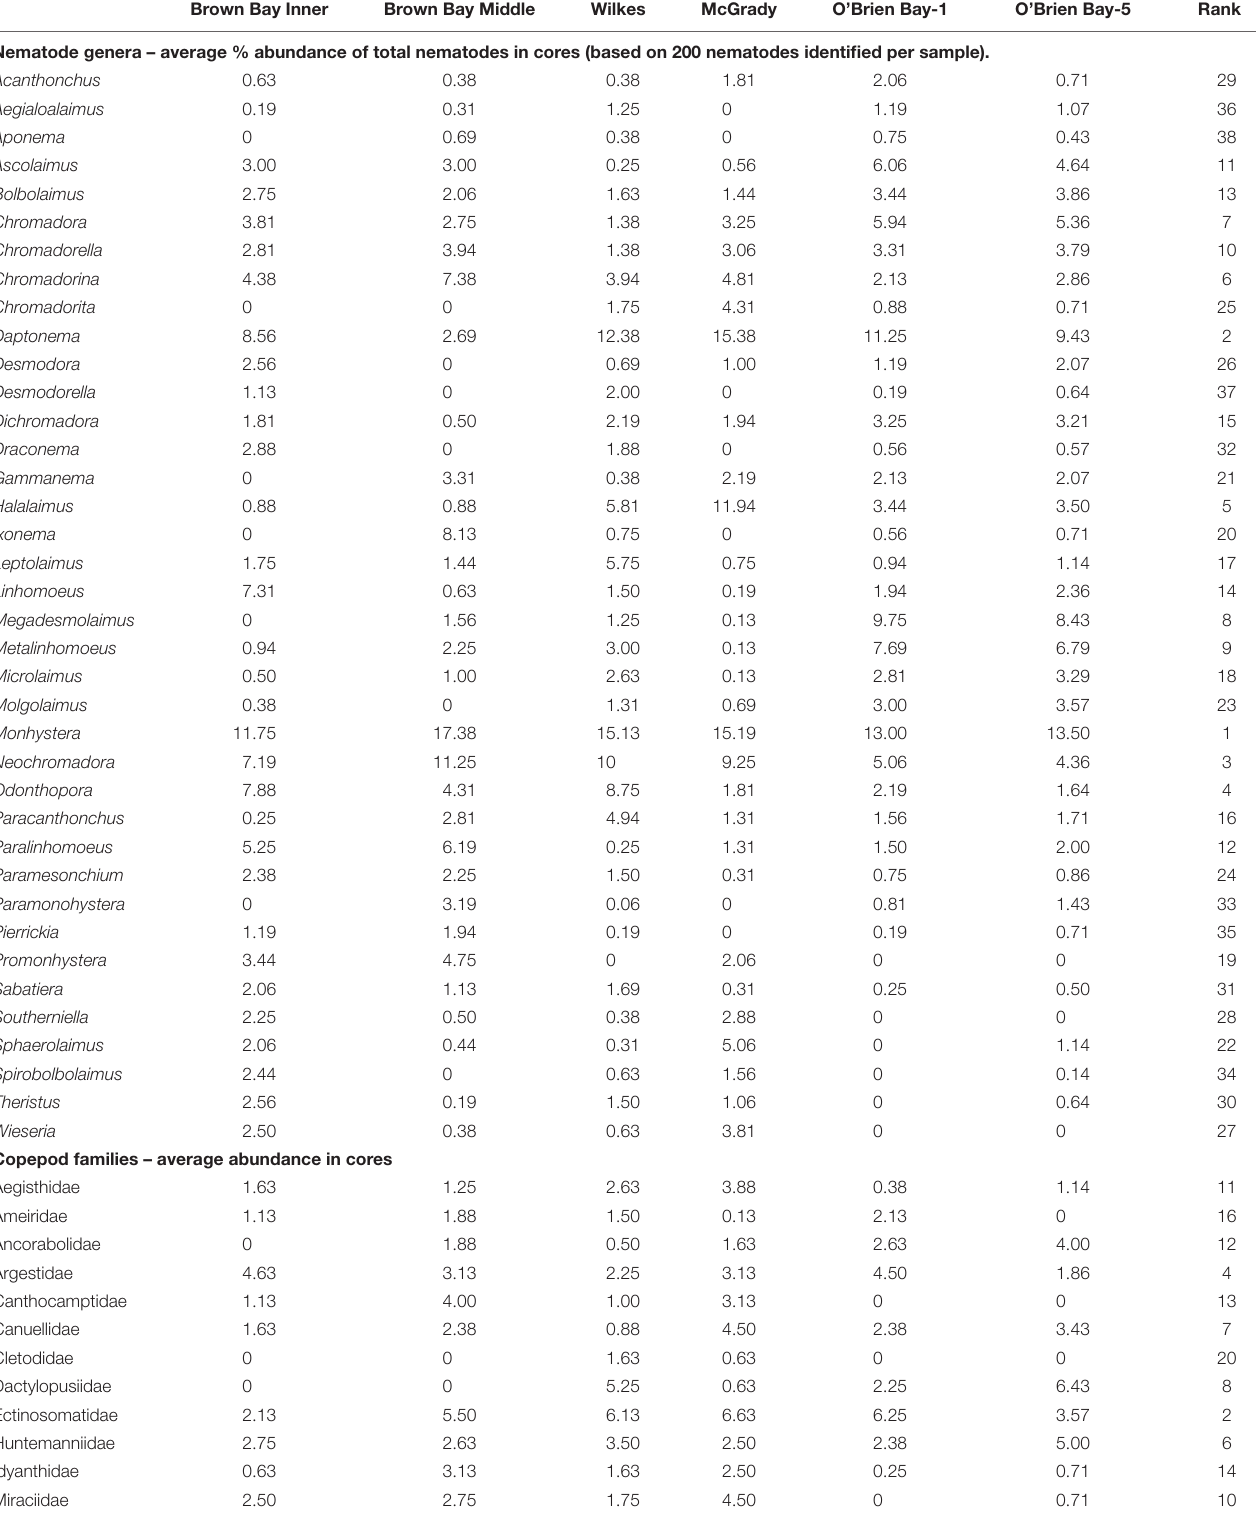
TABLE 1 | Average abundances of nematodes and copepods in cores at six locations at Casey Station ( n = 8, except at O’Brien Bay-5 n = 7). Brown Bay Inner Brown Bay Middle Wilkes McGrady O’Brien Bay-1 O’Brien Bay-5